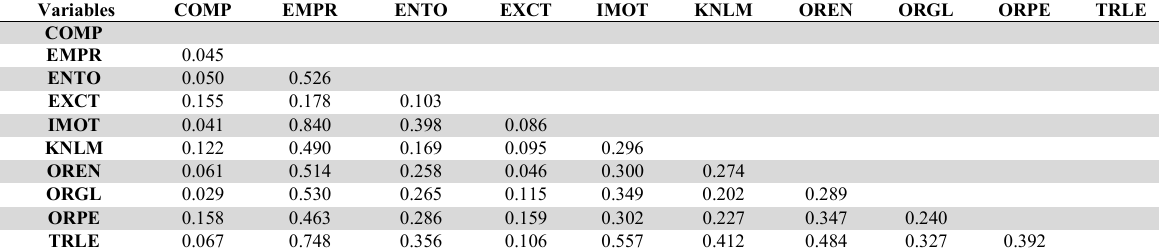
Heterotrait-Monotrait Ratio (HTMT)